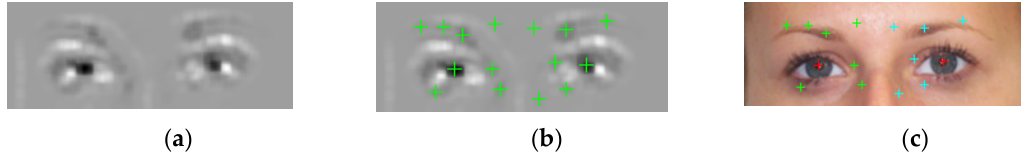
Figure 4. Iris center localization. ( a ) Symmetry transform on the eye region; ( b ) Possible iris center candidates in green; and ( c ) iris selection: left iris candidates in green, right iris candidates in cyan, and selected iris centers in red.